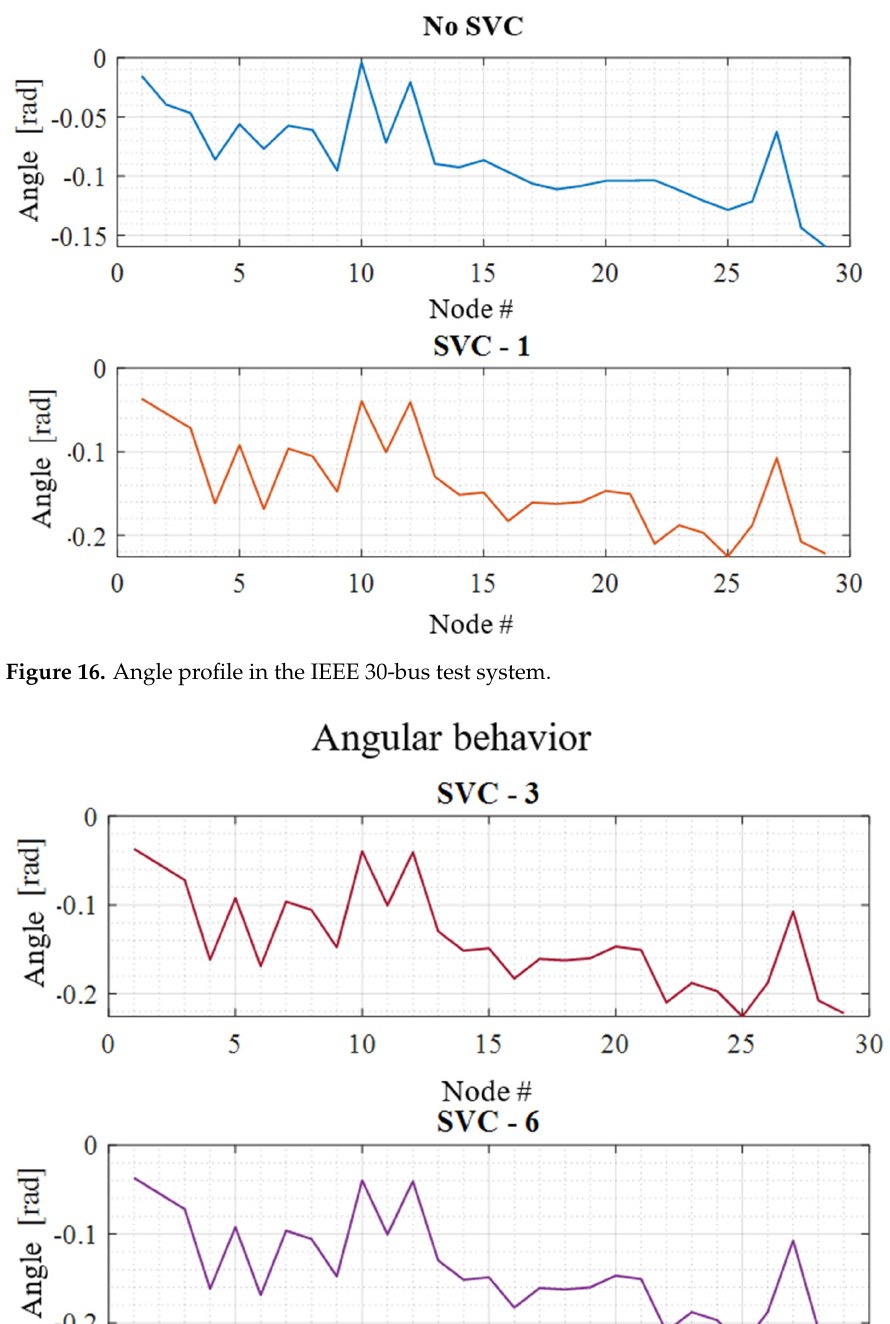
20 of 27 Figure 15. Voltage profile in the IEEE 30-bus test system: SVC 3 and 6. In addition, the voltage profile is reorganized such that it attempts to reach a value of one. Nevertheless, it is verified that an SVC with a capacity of 1 Mvar is the one that